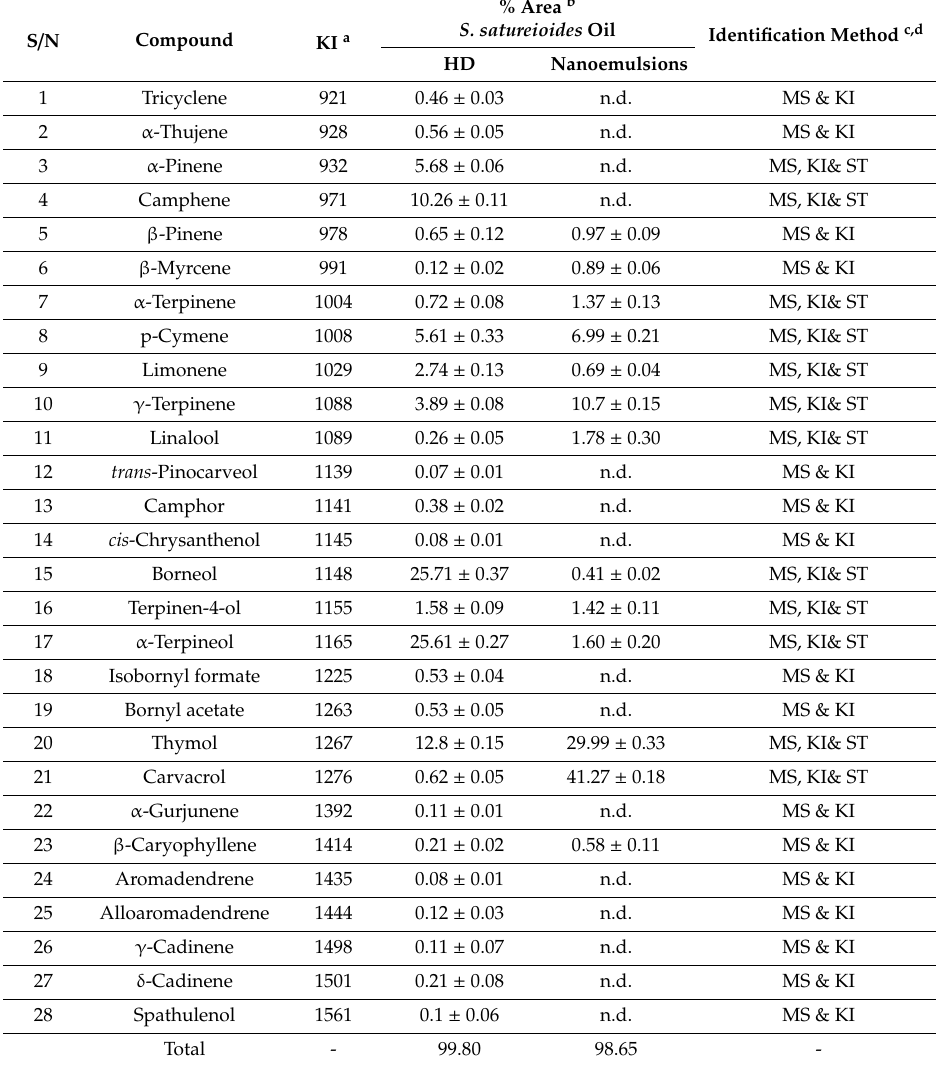
Table1. Volatileconstituentsidentifiedfromthehydrodistilled(HD)andnanoemulsionsof S.satureioides essential oil using